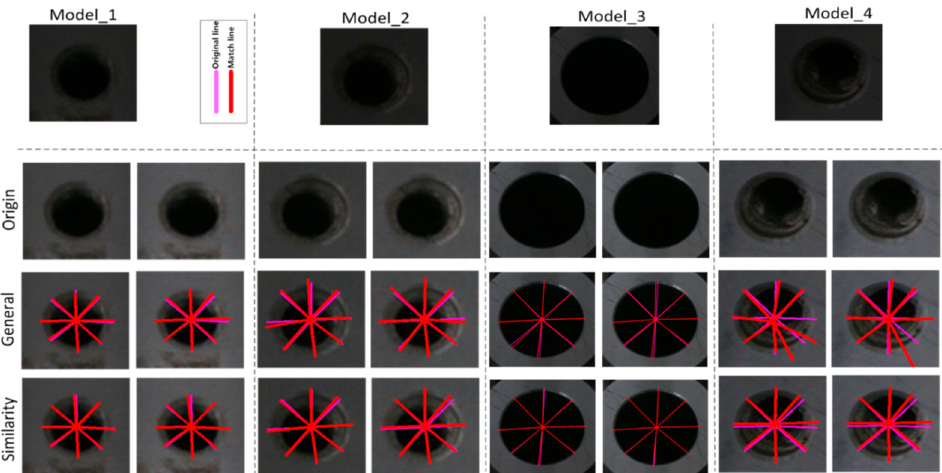
Figure 10. Matching results of different illumination images by robust enhancement algorithm.